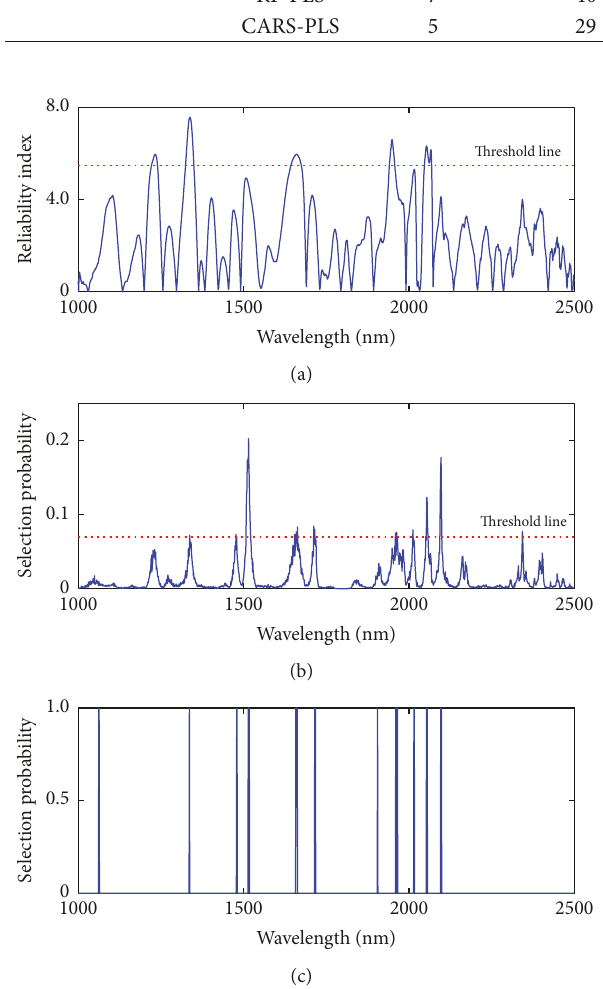
Figure 6: Results of variable screening of moisture dataset by (a) MC-UVE, (b) RF, and (c)